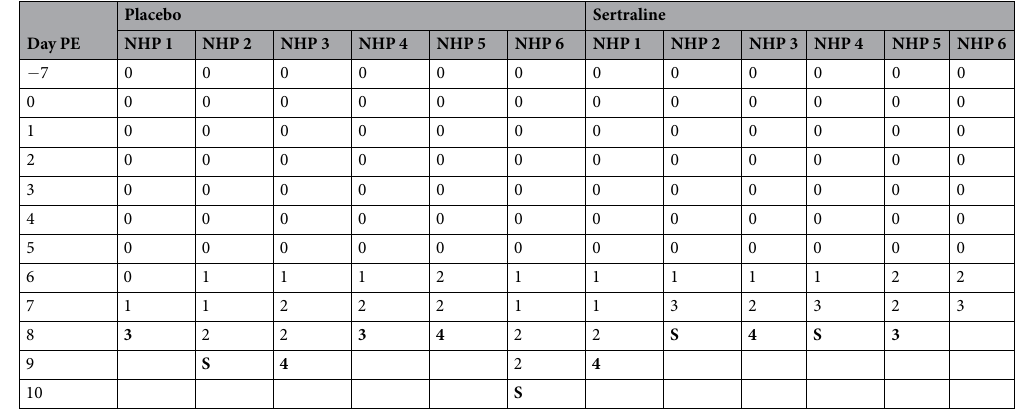
Table 1. Clinical responsiveness scores for study subjects. Cage-side unanesthetized responsiveness was scored on the following 5-point range, where a score of 4 met primary endpoint criteria and 3 initiated secondary criteria evaluation: 0 = alert, responsive, normal activity, free of disease signs or exhibits only resolved/resolving disease signs; 1 = slightly diminished general activity, subdued but responds normally to external stimuli;